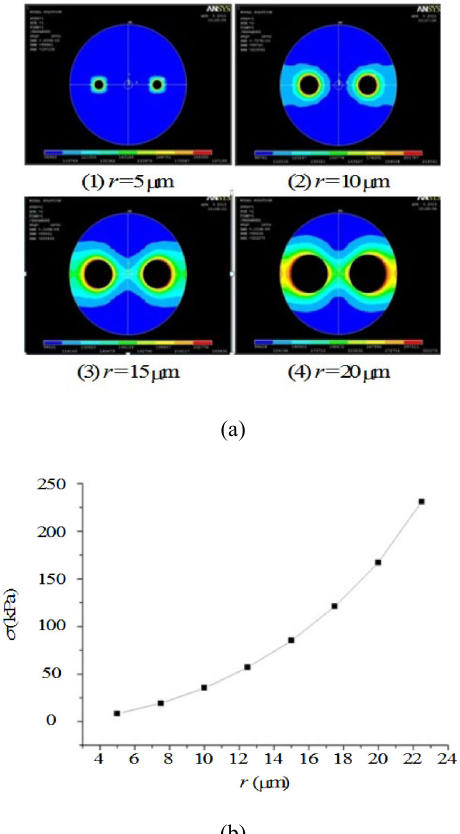
Fig. 2 Strain distributions of the circular-core side-hole fiber: (a) strain field distribution of different side-hole fibers (the radii of the holes are 5 µ m, 10 µ m, 15 µ m, and 20 µ m, respectively. The length between the centers of the core and holes is fixed at 31.25 µ m) and (b) strain difference changes with radii of the side holes.